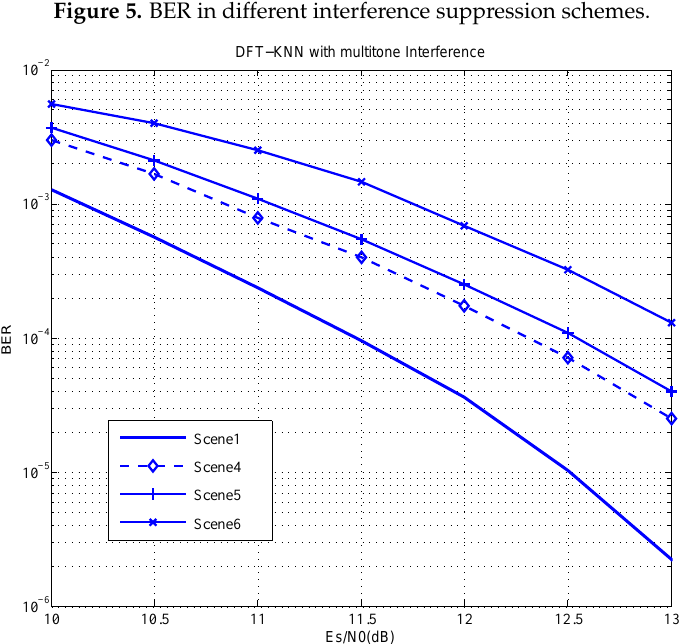
Figure 6. BER in different interference